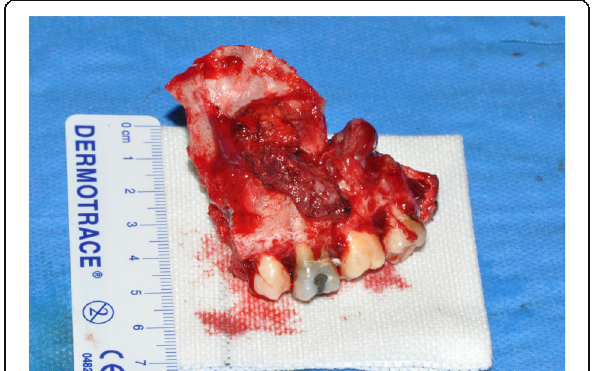
Fig. 8 Pt no. 2. The extended portion of the left maxilla removed after maxillectomy